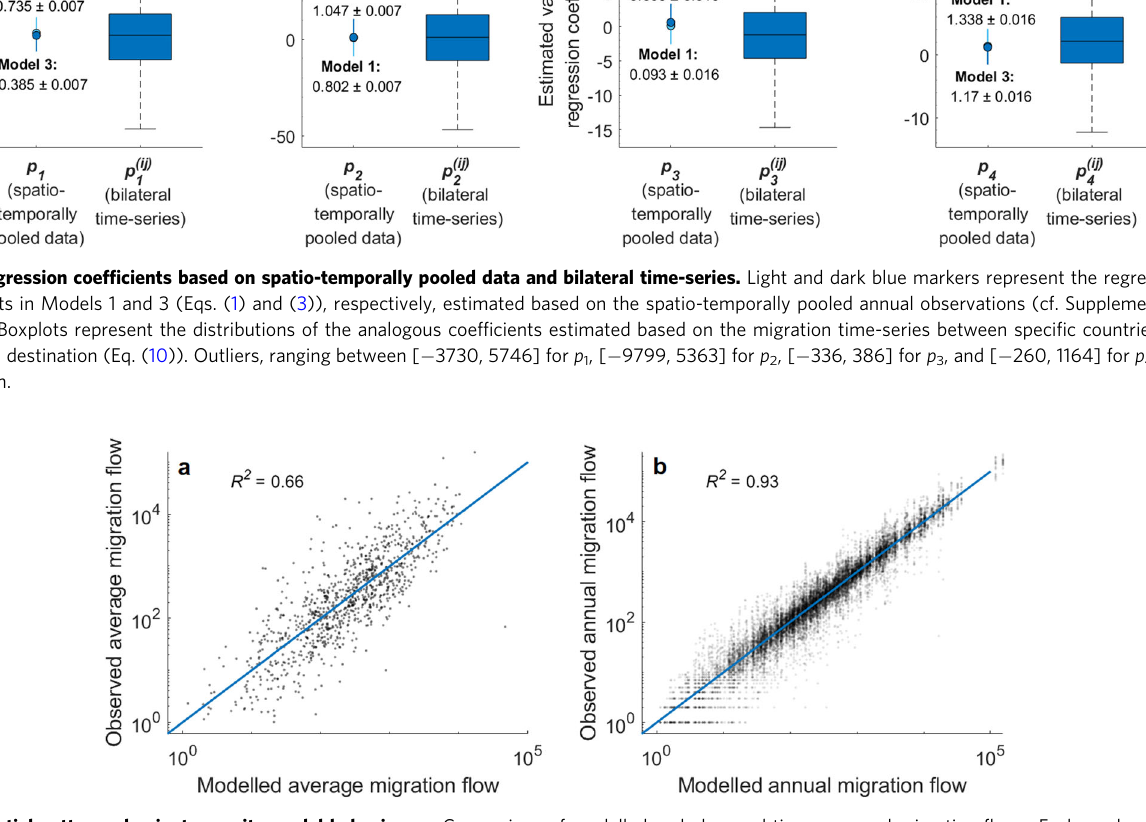
Fig. 6 Spatial patterns dominate gravity model behaviour. a Comparison of modelled and observed time-averaged migration fl ows. Each marker represents the mean fl ow from a country of origin i to a country of destination j across all available years. b Comparison of observed annual migration fl ows against a time-invariant, fi xed-effects-only model. The lack of temporal variation in the modelled data is visible in the form of vertical patterns, representing country pairs for which the modelled fl ow is constant over time. Blue lines represent 1:1 relationships. HUMANITIES AND SOCIAL SCIENCES COMMUNICATIONS| (2022) 9:56